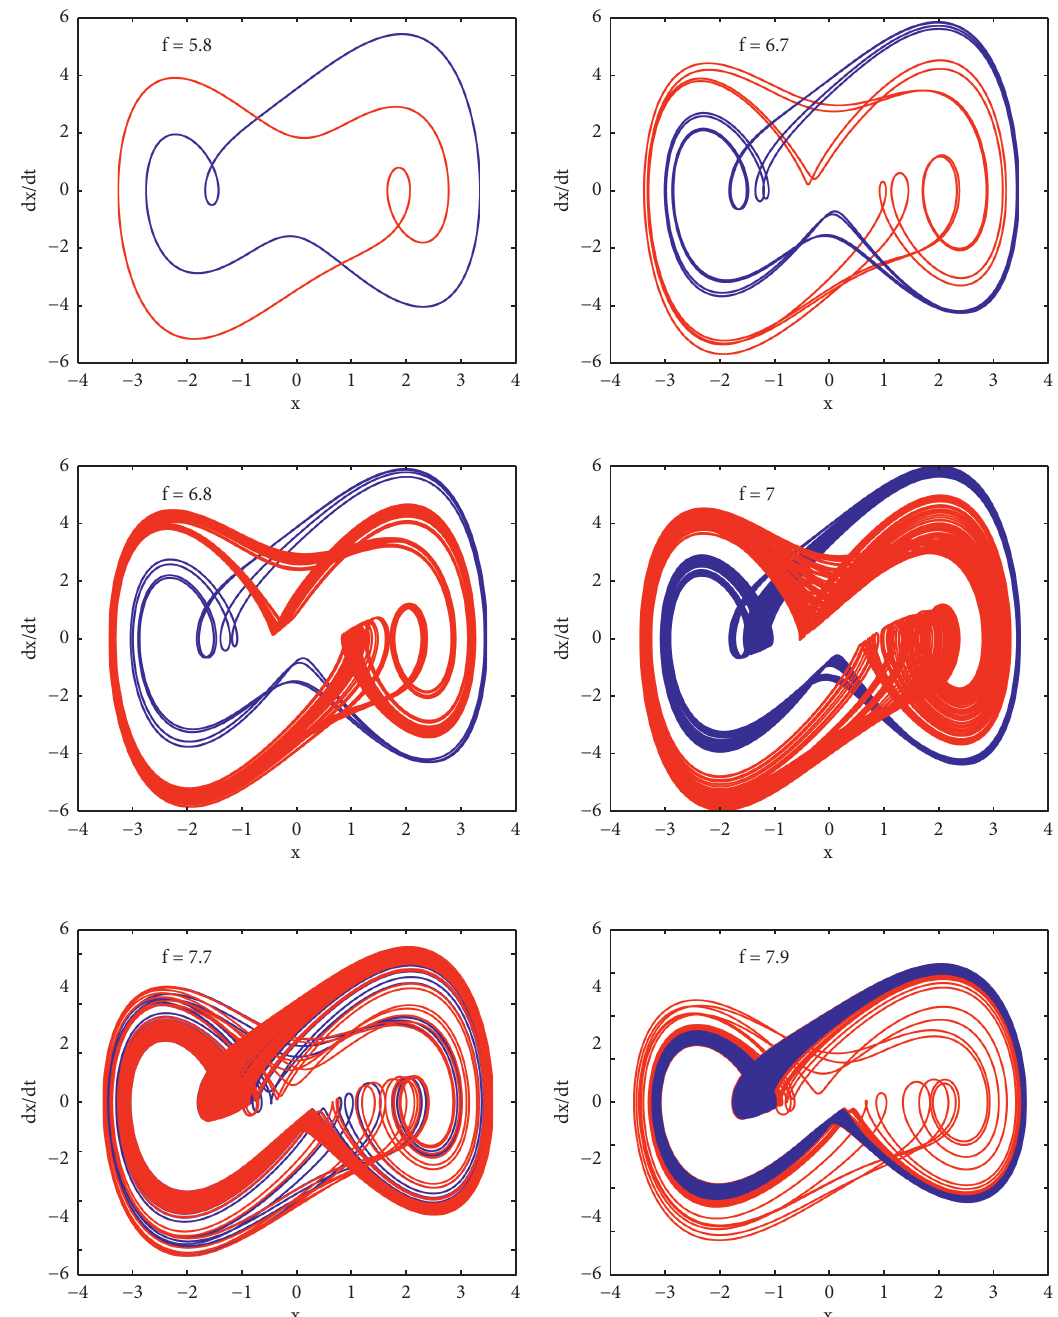
Figure 6: Various phase portraits illustrating the coexistence of two attractors for different values of f with the parameters of Figure